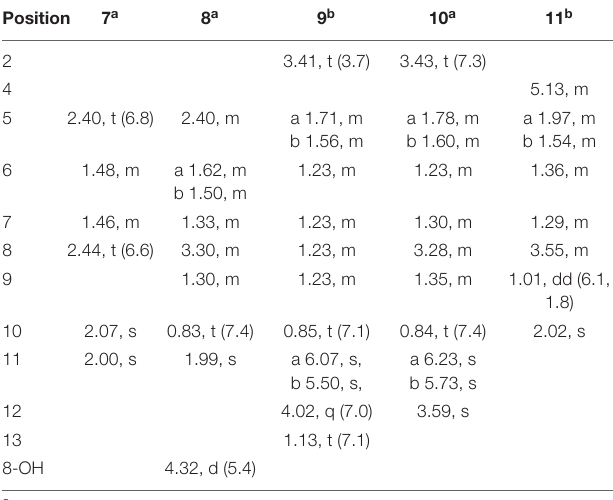
TABLE 3 | 1 H NMR data for compounds 7–11 ( δ in ppm) in DMSO- d 6